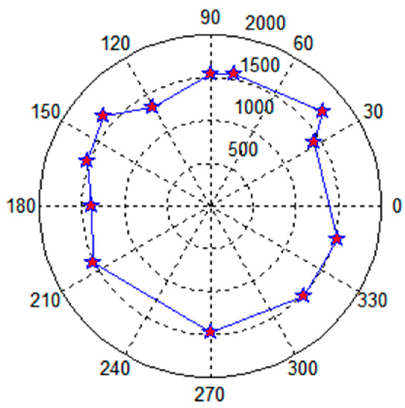
Figure 8. The tank speed curve.